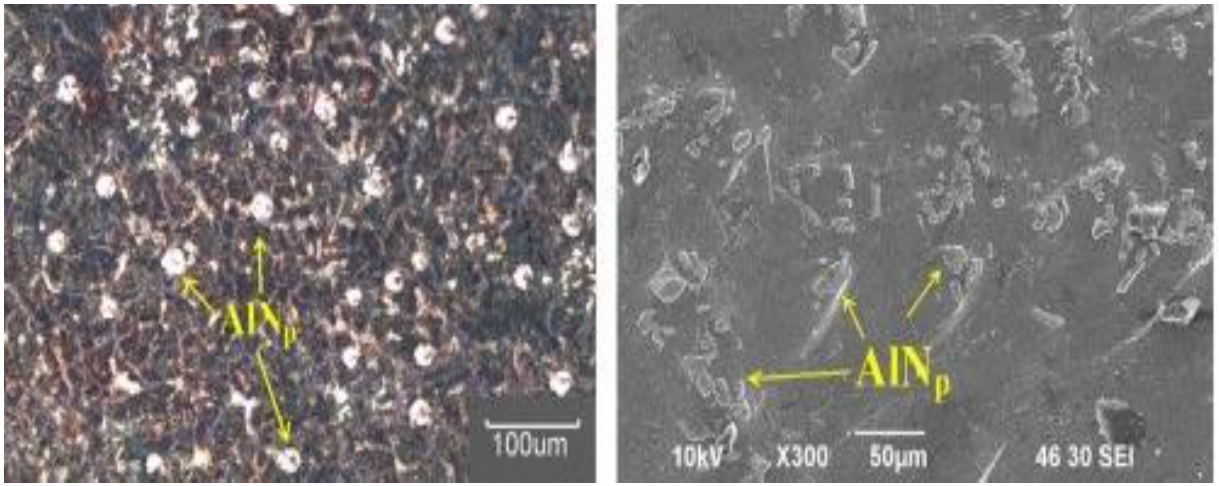
Figure 2. Micrographs of AA6061-AIN composite.